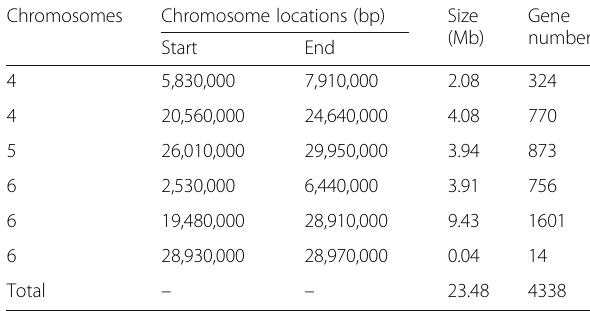
Table 3 Information of the association region by the